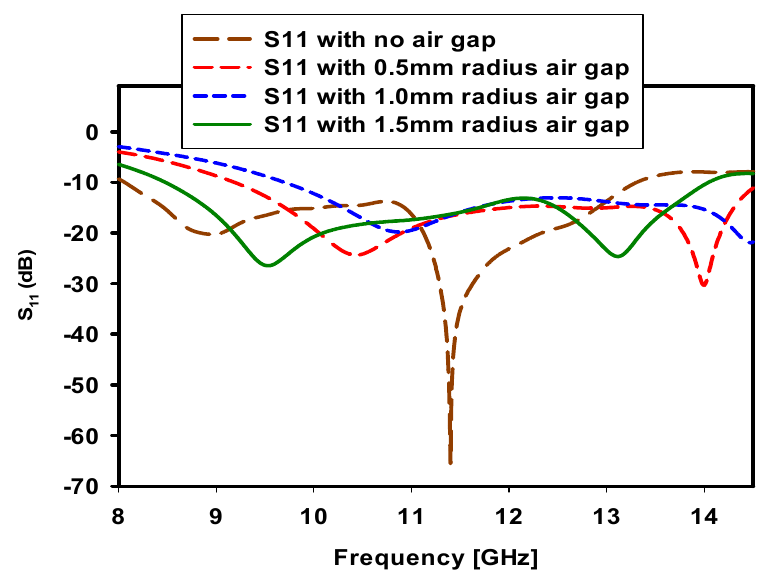
Figure 5. Effect of changing the air gap radius on the Reflection Coefficient.